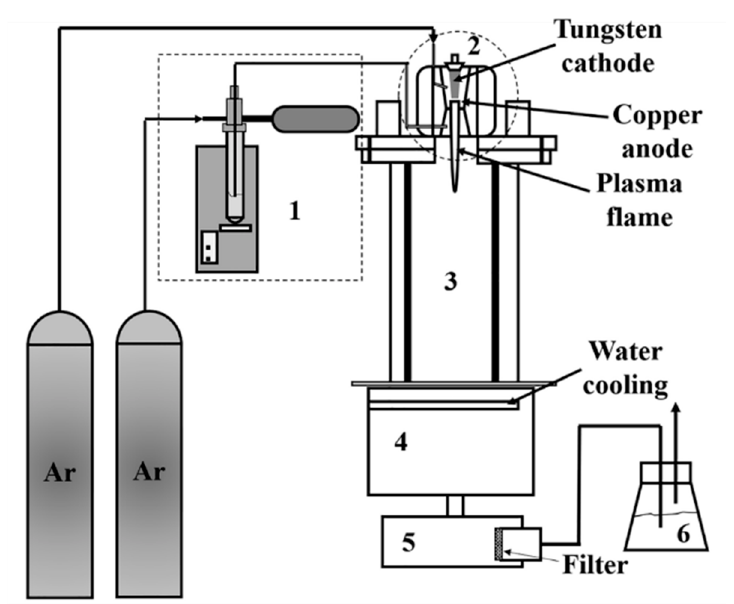
Figure 4. Schematic diagram of plasma reactor system: (1) powder feeding system, (2) plasma gun, (3) reactor chamber, (4) cooling chamber, (5) powder collector, and (6) scrubber. Reproduced with permission from Ref. [15]; published by IOP Publishing, 2018.